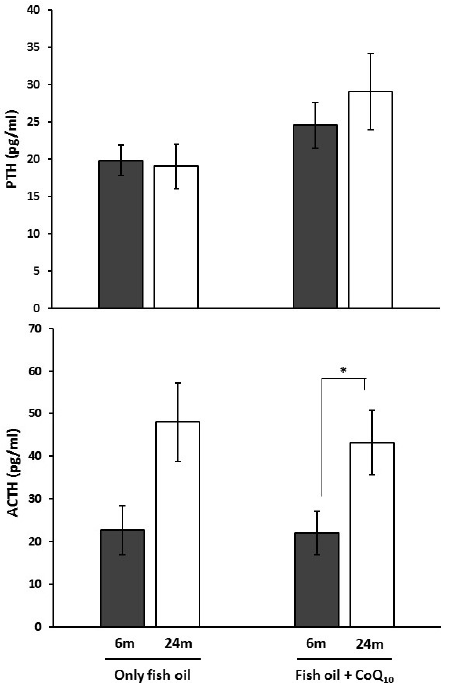
Figure 5. Effects of supplementation with coenzyme Q 10 (CoQ 10 ) on circulating levels of parathyroid hormone and adrenocorticotropin (ACTH) in 6- and 24-month-old (m) rats fed fish oil as dietary fat. Results are expressed as mean ± standard error of mean of six animals. * Statistically significant differences ( p < 0.05) determined by the Mann–Whitney U ‐ test.